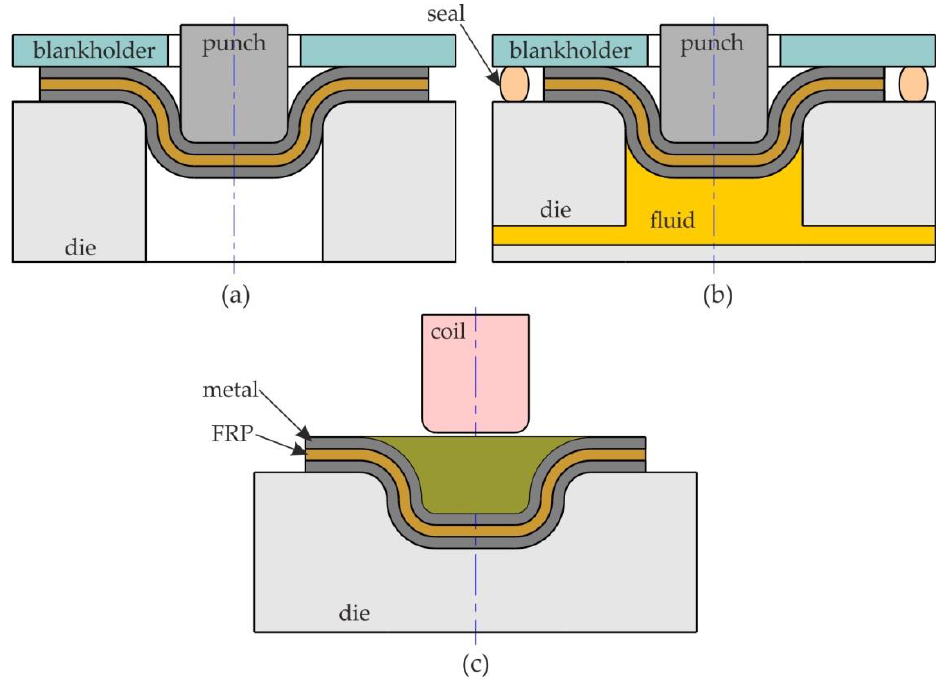
Figure 2. Die forming methods: ( a ) stamping, ( b ) hydroforming, and ( c ) electromagnetic forming. Laminated ISFed metal sheets can be used in the fabrication of parts with different inner and outer conditions such as mechanical strength, wear resistance, and